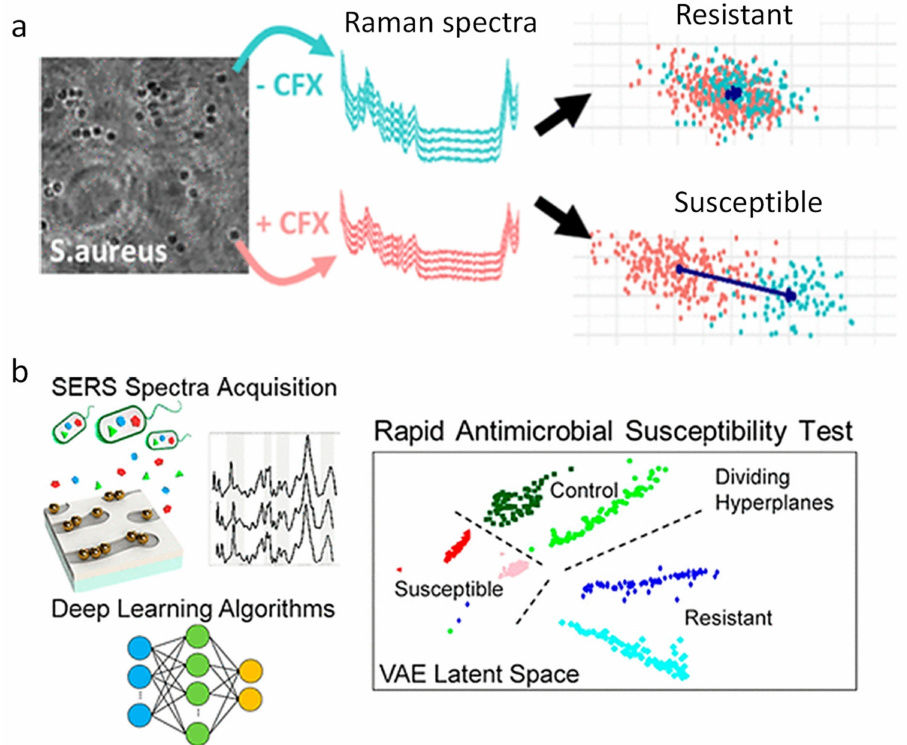
Figure 7. Rapid AST by Raman spectroscopy and SERS. ( a ) Rapid AST of MRSA by Raman spectroscopy with LDA. ( b ) Deep learning and SERS spectra of bacterial lysate for rapid AST. MRSA, methicillin-resistant Staphylococcus aureus ; LDA, linear discriminant analysis. Reprinted from reference [57,81] with